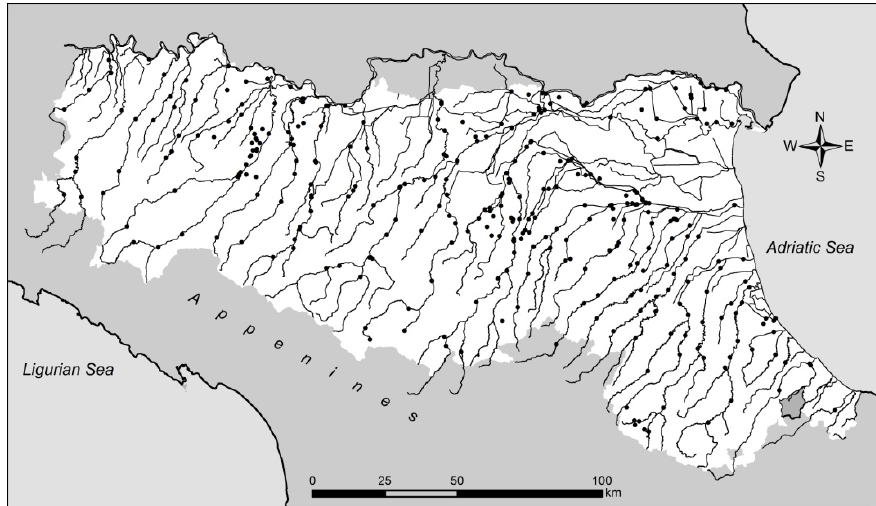
Figure 4. Telemetry water level gauges network of Emilia-Romagna.